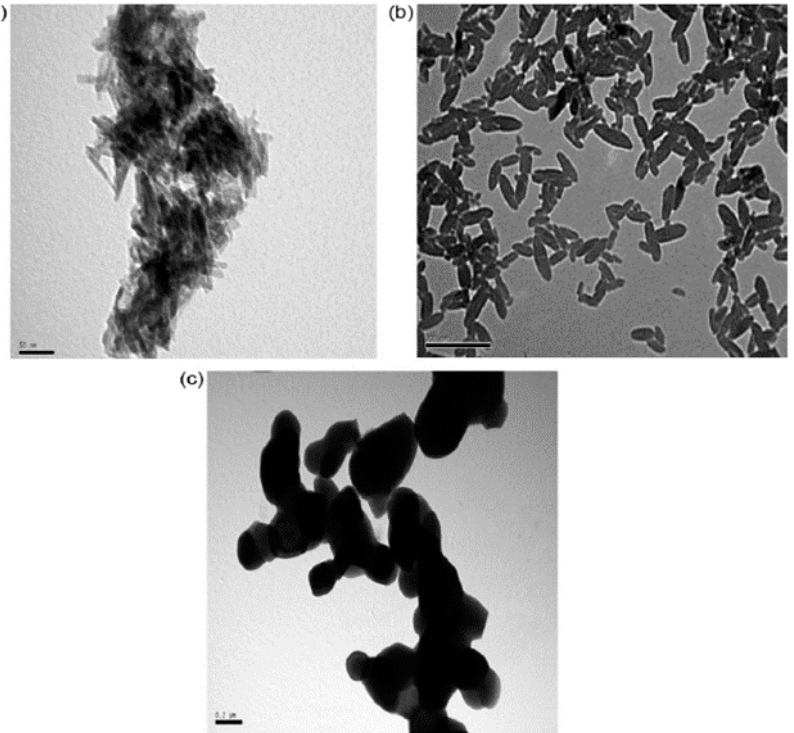
Figure 5. TEM images of the synthesized hydroxyapatite nanocrystals ( a ) before calcination, ( b ) calcined at 600 °C, and ( c ) calcined at 900 °C [63].